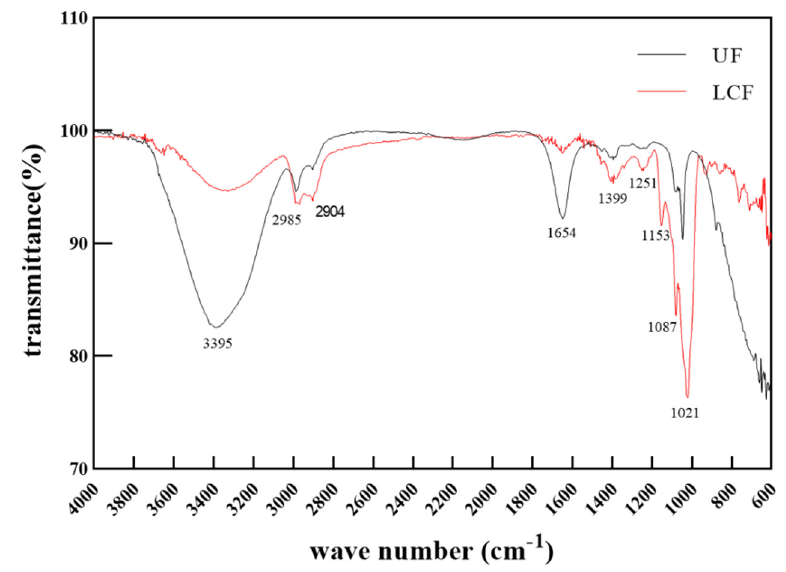
Figure 3. FT − IR spectra of UF and LCF. UF: unfermentation; LCF: single microbial fermentation with L. curvatus.